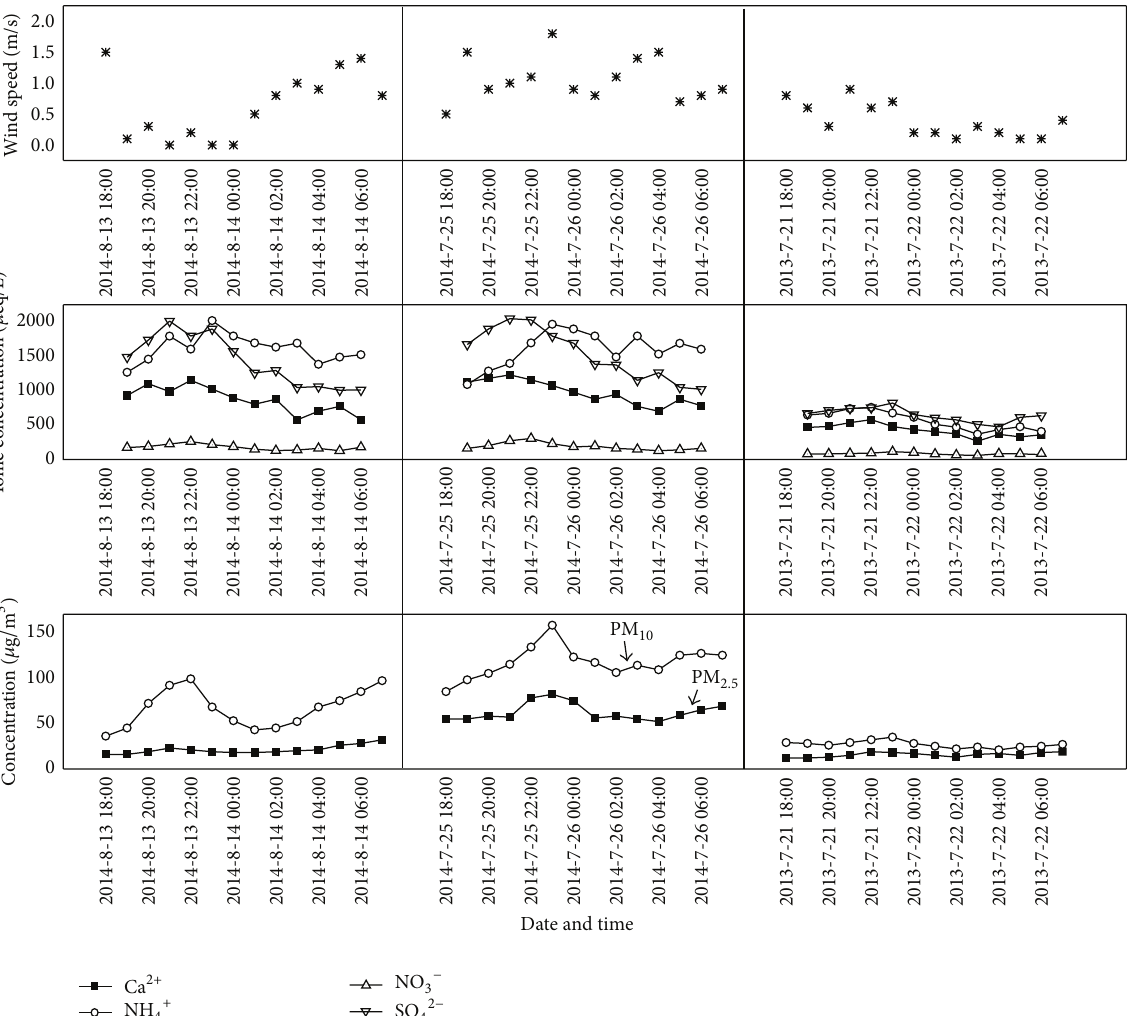
Figure 4: Hourly concentrations of ions, PM 10 , PM 2.5 , and wind speed during experimental